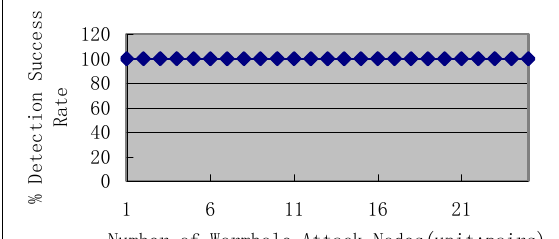
Fig.7. Detection Rate